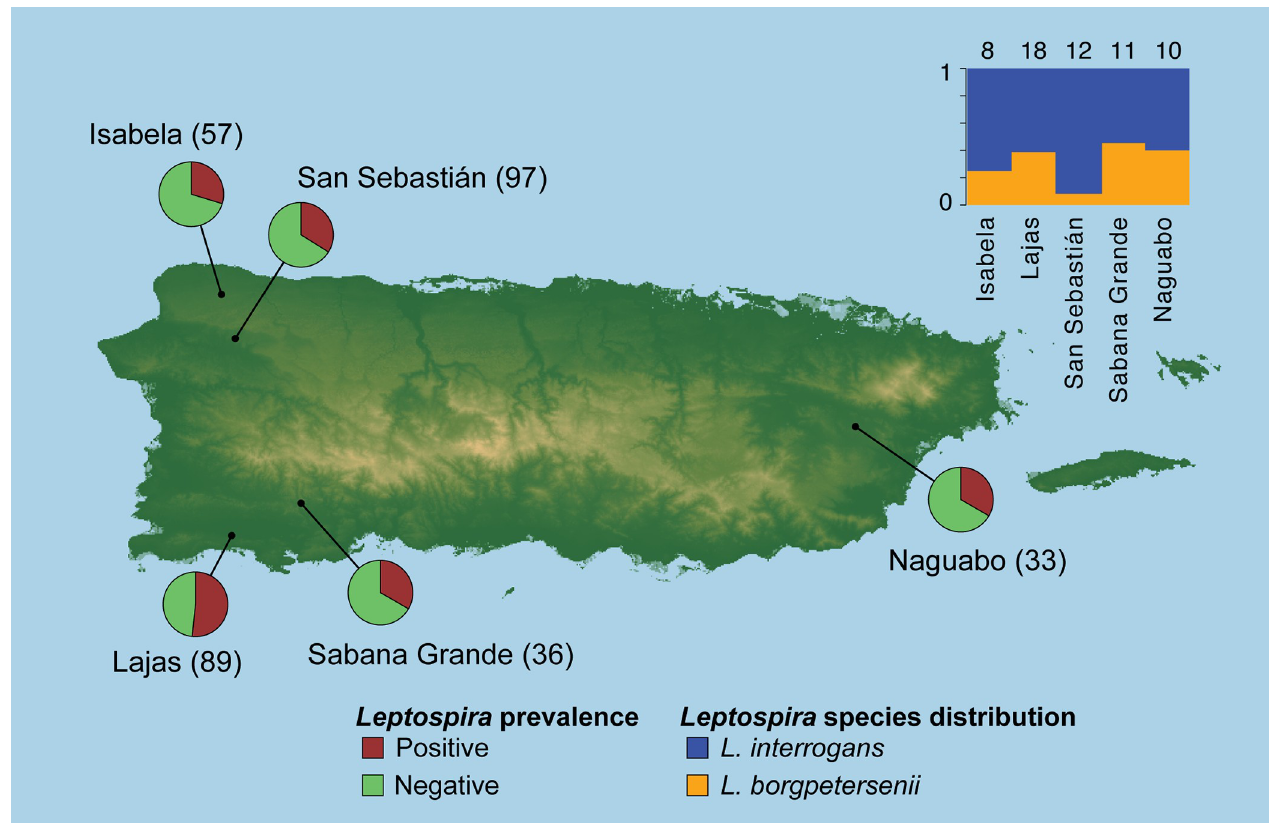
Fig 1. Leptospira prevalence for small invasive mammals ( Mus , Rattus , and Herpestes ) collected from five farms in Puerto Rico. Pie charts represent the total ratio of positive and negative individuals captured at each farm location. The bar chart (top right) represents the ratio of L . interrogans and L . borgpertersenii detected in the animal reservoirs at each site. Sample sizes for each farm location are indicated with parentheses. Prevalence per site is overlaid on an elevation map based on the Puerto Rico, PR 1 arc-second MHW DEM [68]. Open source raster accessed from: https://www.ngdc.noaa.gov/dem/